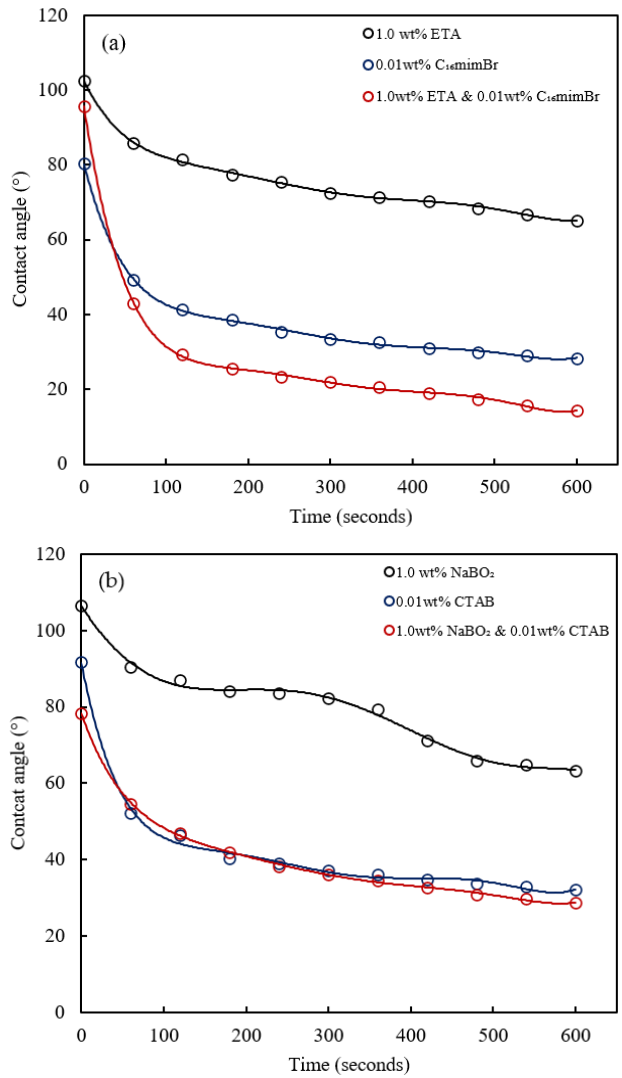
Figure 15. The dynamic contact angle of ( a ) ETA, C 16 mimBr and the ETA–C 16 mimBr system and ( b ) NaBO 2 , CTAB and the NaBO 2 – CTAB system on a carbonate surface.